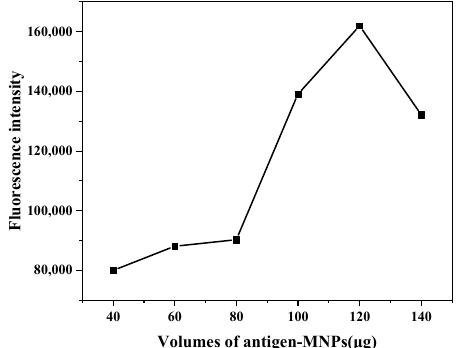
Figure 3. Optimization of capture probe addition.